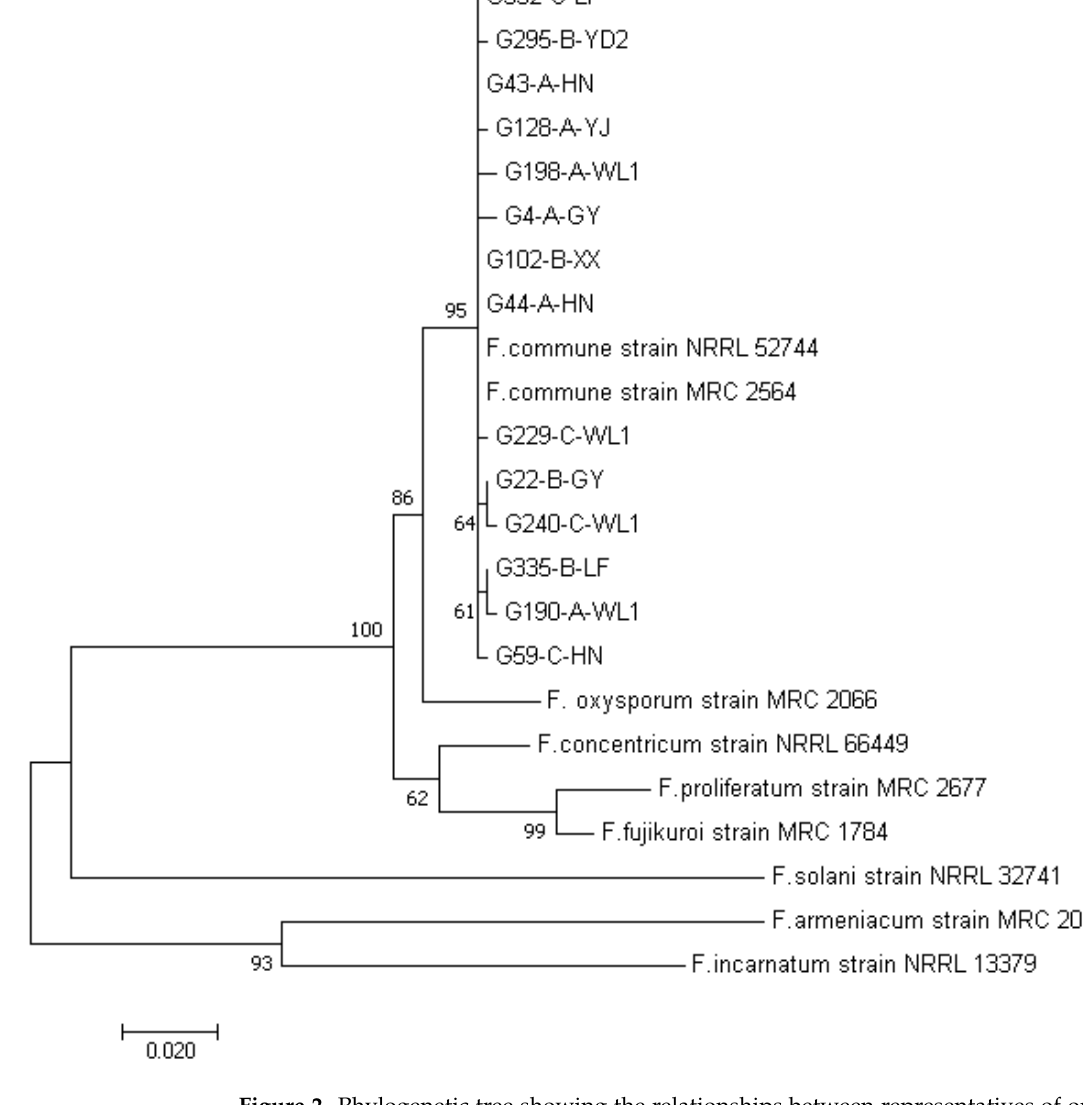
Figure 2. Phylogenetic tree showing the relationships between representatives of our F. commune strains and those of closely related species based on tef1 α sequences. Only one representative strain for each of the 14 tef1 α sequence types observed in our total sample was included in this figure.